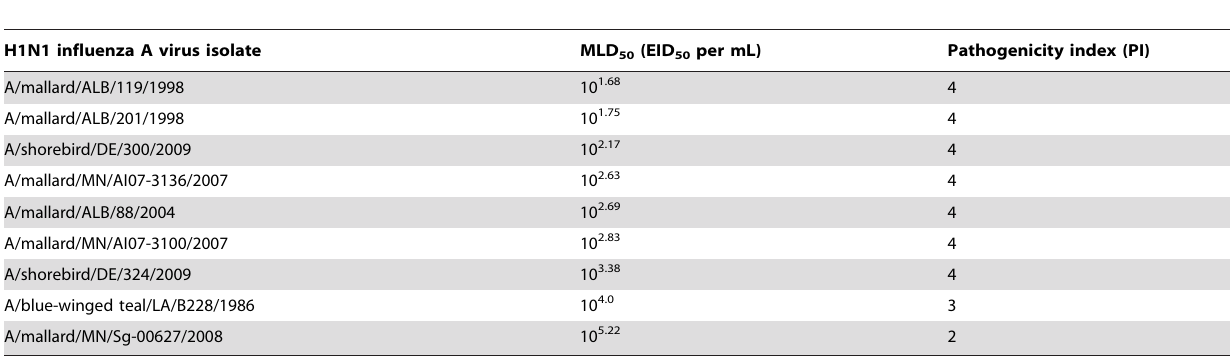
Table 2. Fifty percent mouse lethal dose (MLD 50 ) is inversely related to the pathogenicity index of avian H1N1 isolates.